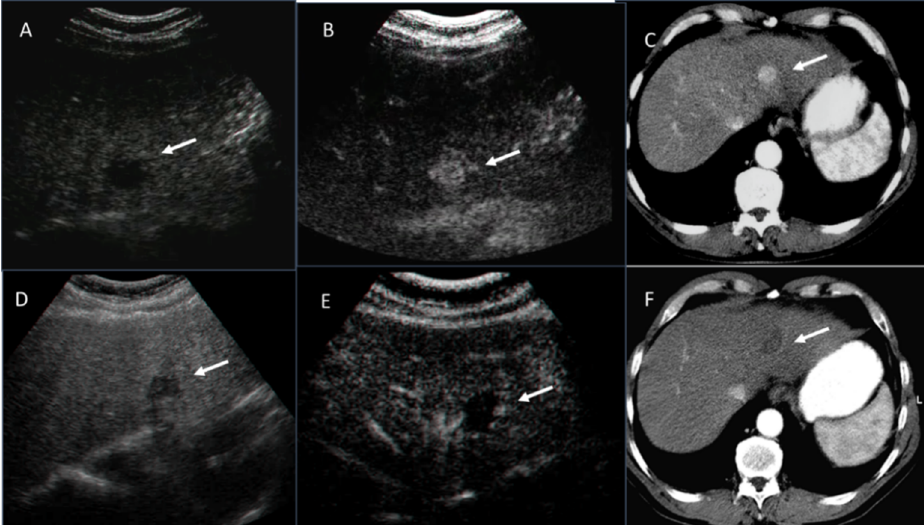
Figure 7. HCC is hypoechoic on US study ( A ) with hyperenhancement during arterial phase in CEUS ( B ) and CT studies ( C ). Post-RFA treatment, the ablated lesion is heterogeneous hypoechoic on US study ( D ) with no enhancement (arrow) during arterial phase in CEUS ( E ) and CT ( F ) studies.